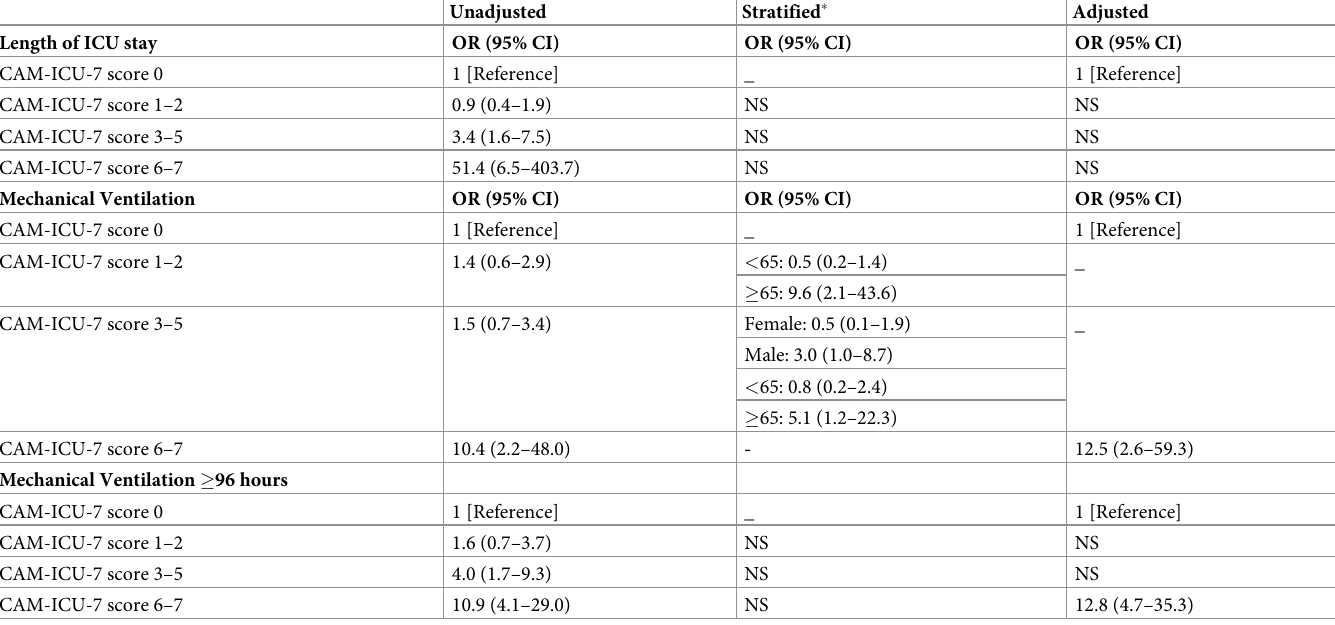
Table 4. Unadjusted, adjusted and stratified odds ratio estimates associations between prolonged length of ICU stay ( � 7 days) or mechanical ventilation (ever/ never, � 96 hours) and CAM-ICU-7 score. Unadjusted Stratified � Adjusted